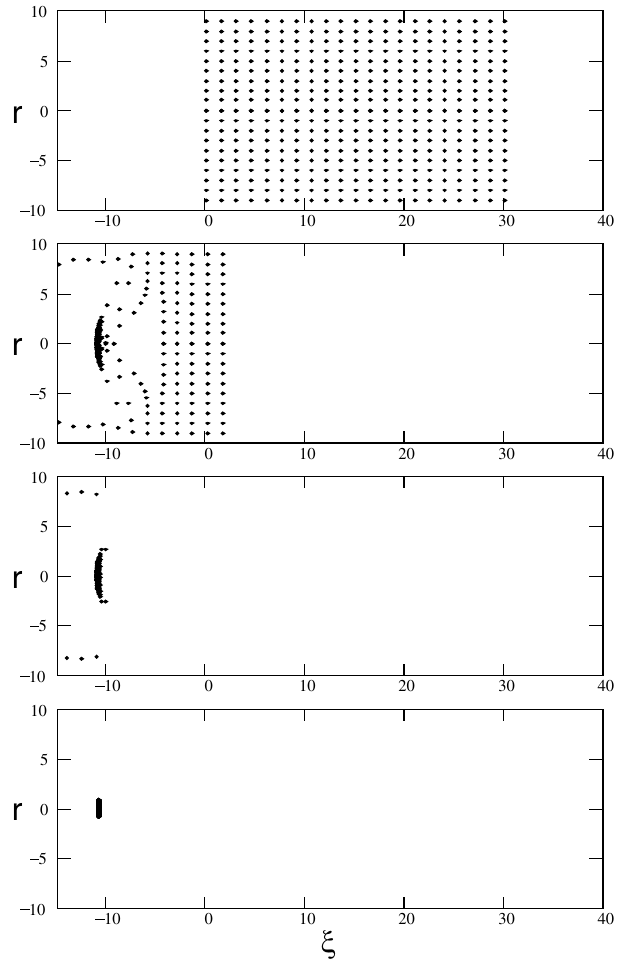
VIDEO 1. The movie and snapshots from it demonstrating the trapping and acceleration of an initially monoenergetic (cid:2) 2 , m (cid:14) 1 : 14 MeV ) e -bunch in a channel-guided c 2 (cid:6) ( p e 0 0 laser wakefield. The snapshots show the e -bunch (dots represent the electrons) at laser pulse propagation distances 0, 43 & , and 239 & . The initial bunch length is L 62 & p p the laser pulse (not shown) parameters are a